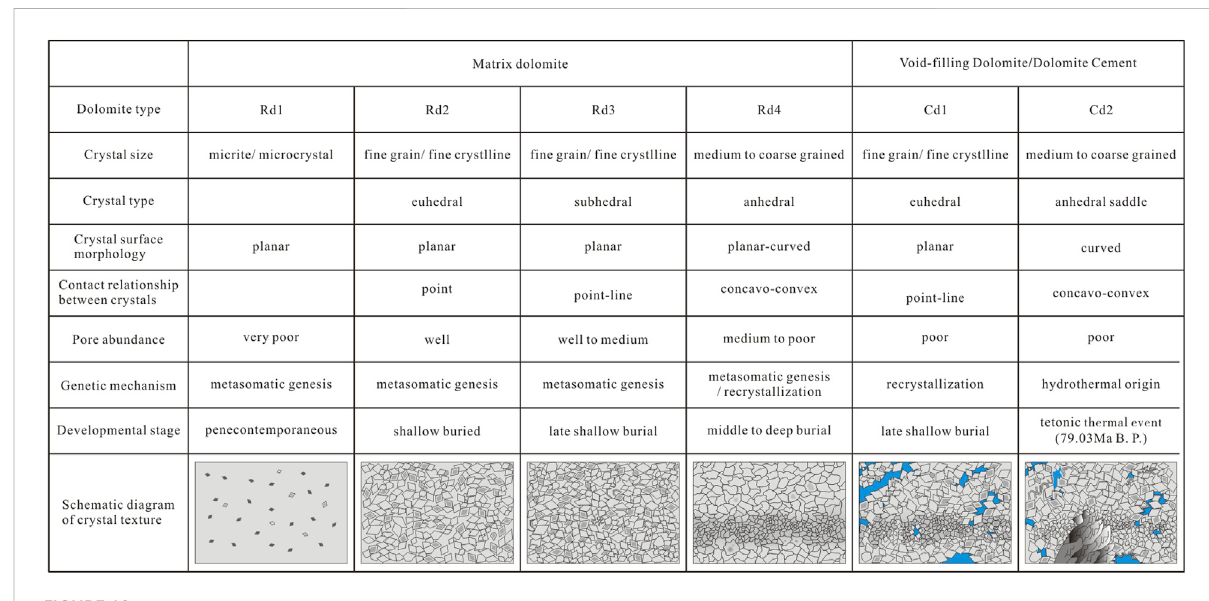
FIGURE 10 Model showing the evolution of diagenetic fabrics among representative dolomites from the study